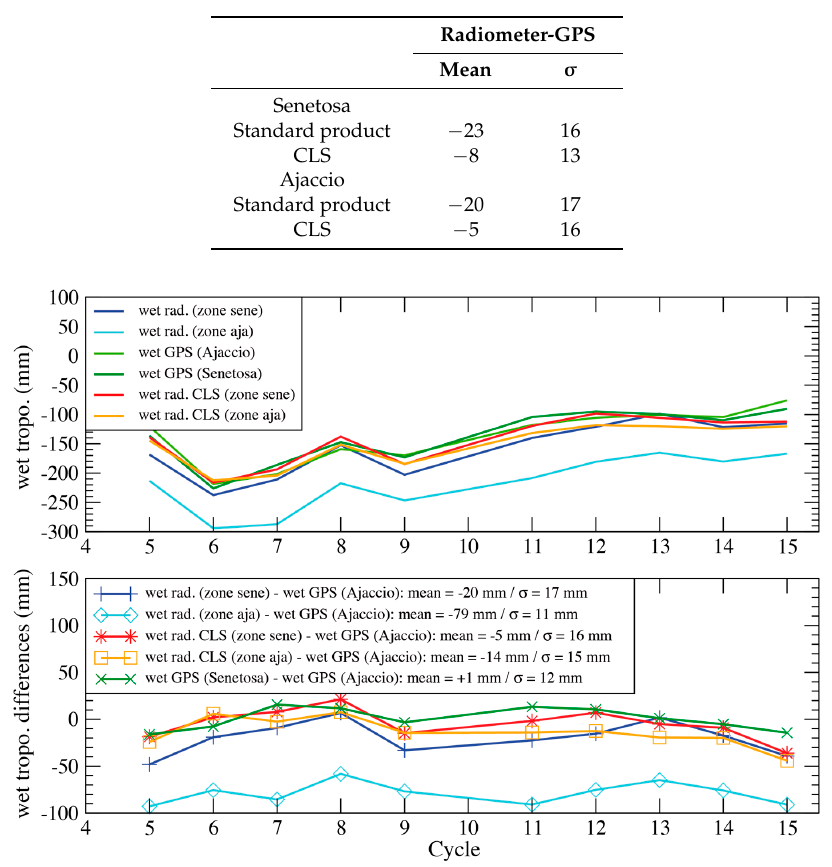
Table 2. Wet tropospheric correction differences on the common cycles (5–15) (in mm).